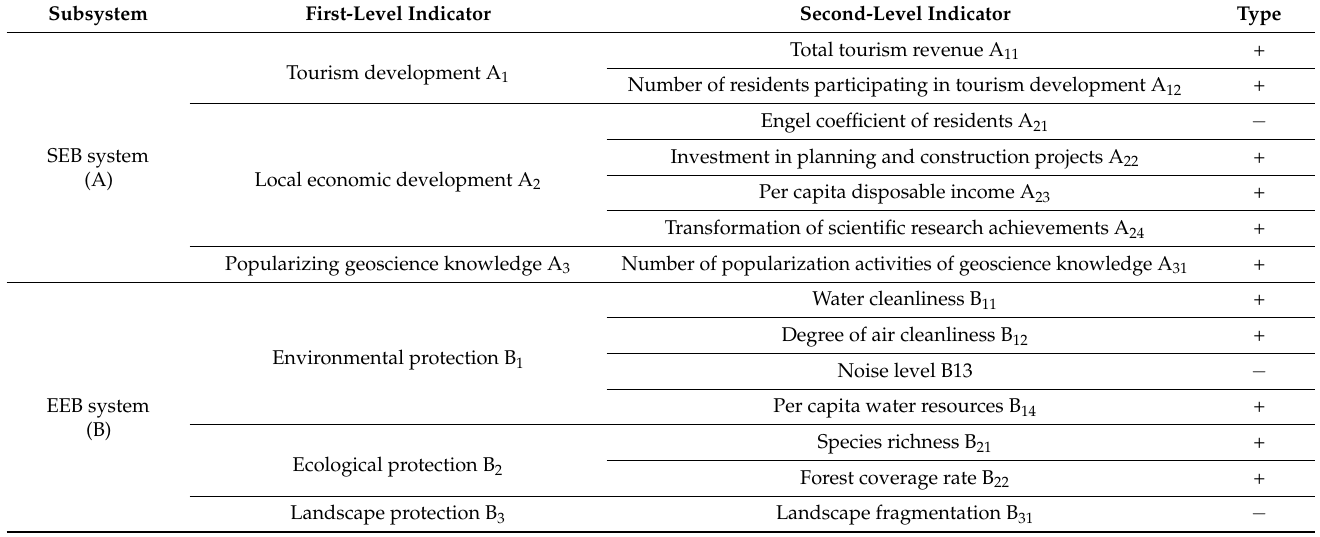
Table 1. The indicator system of SEBs and